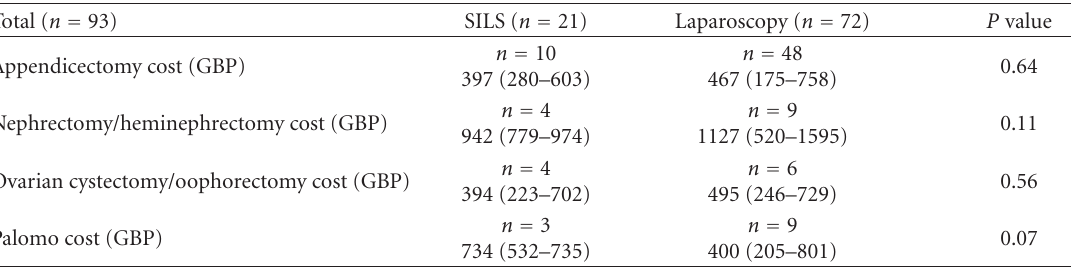
Table 1: Comparison of operative costs, median (range).